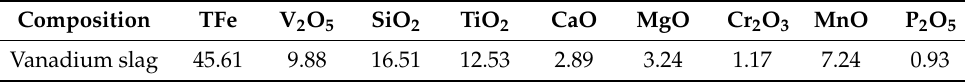
Table 1. Chemical composition (wt%) of vanadium slag in Chengde Iron and Steel Co. Composition TFe V 2 O 5 SiO 2 TiO 2 CaO